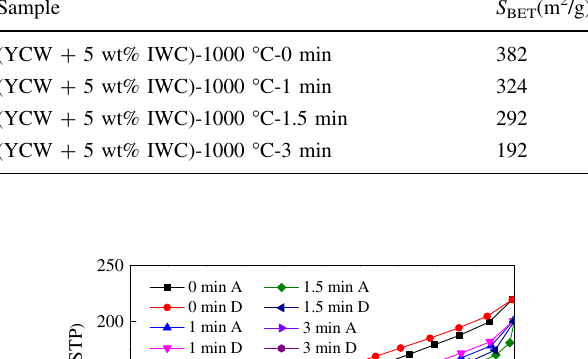
Table 4 Specific surface area of different gasified semi-chars Sample S BET (m 2 /g)